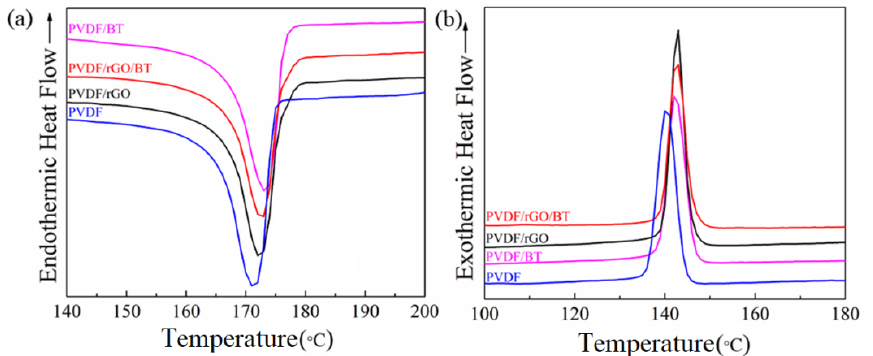
Figure 3. DSC second melting ( a ) and cooling ( b ) curve of PVDF, PVDF/BT, PVDF/rGO, and PVDF/rGO/BT nanocomposite fibers.